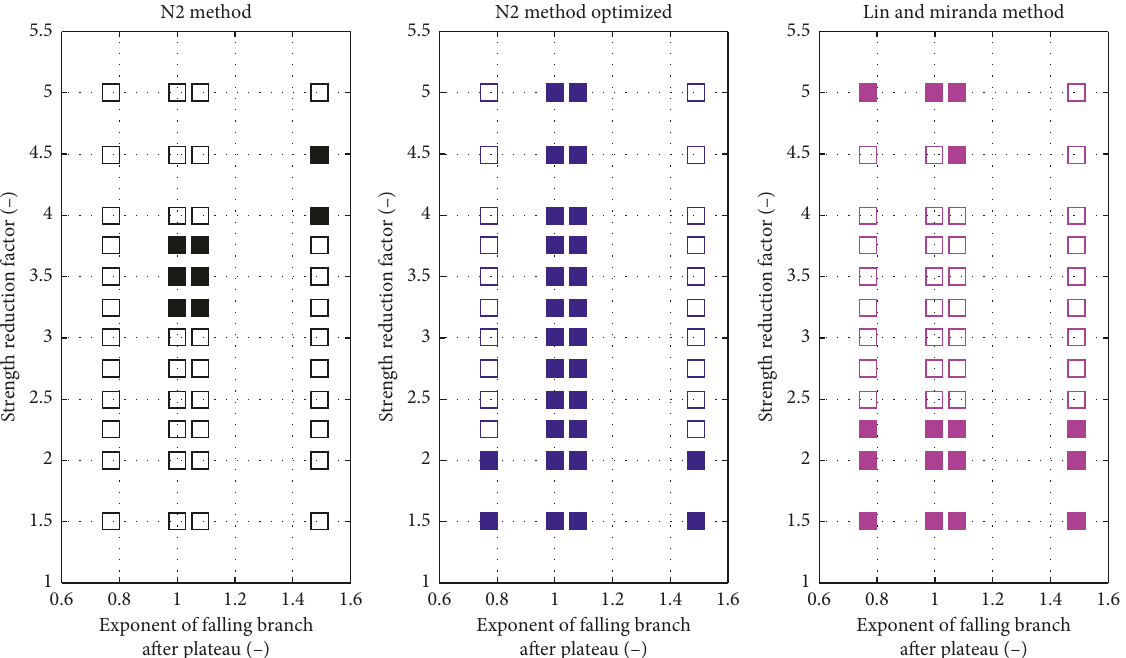
Figure 15: Accuracy assessment of the three investigated methods for soil class D with respect to the exponent of the decreasing branch after the plateau of the response spectrum.